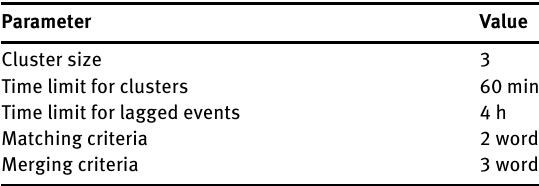
Table 3: Parameter Set for Clustering